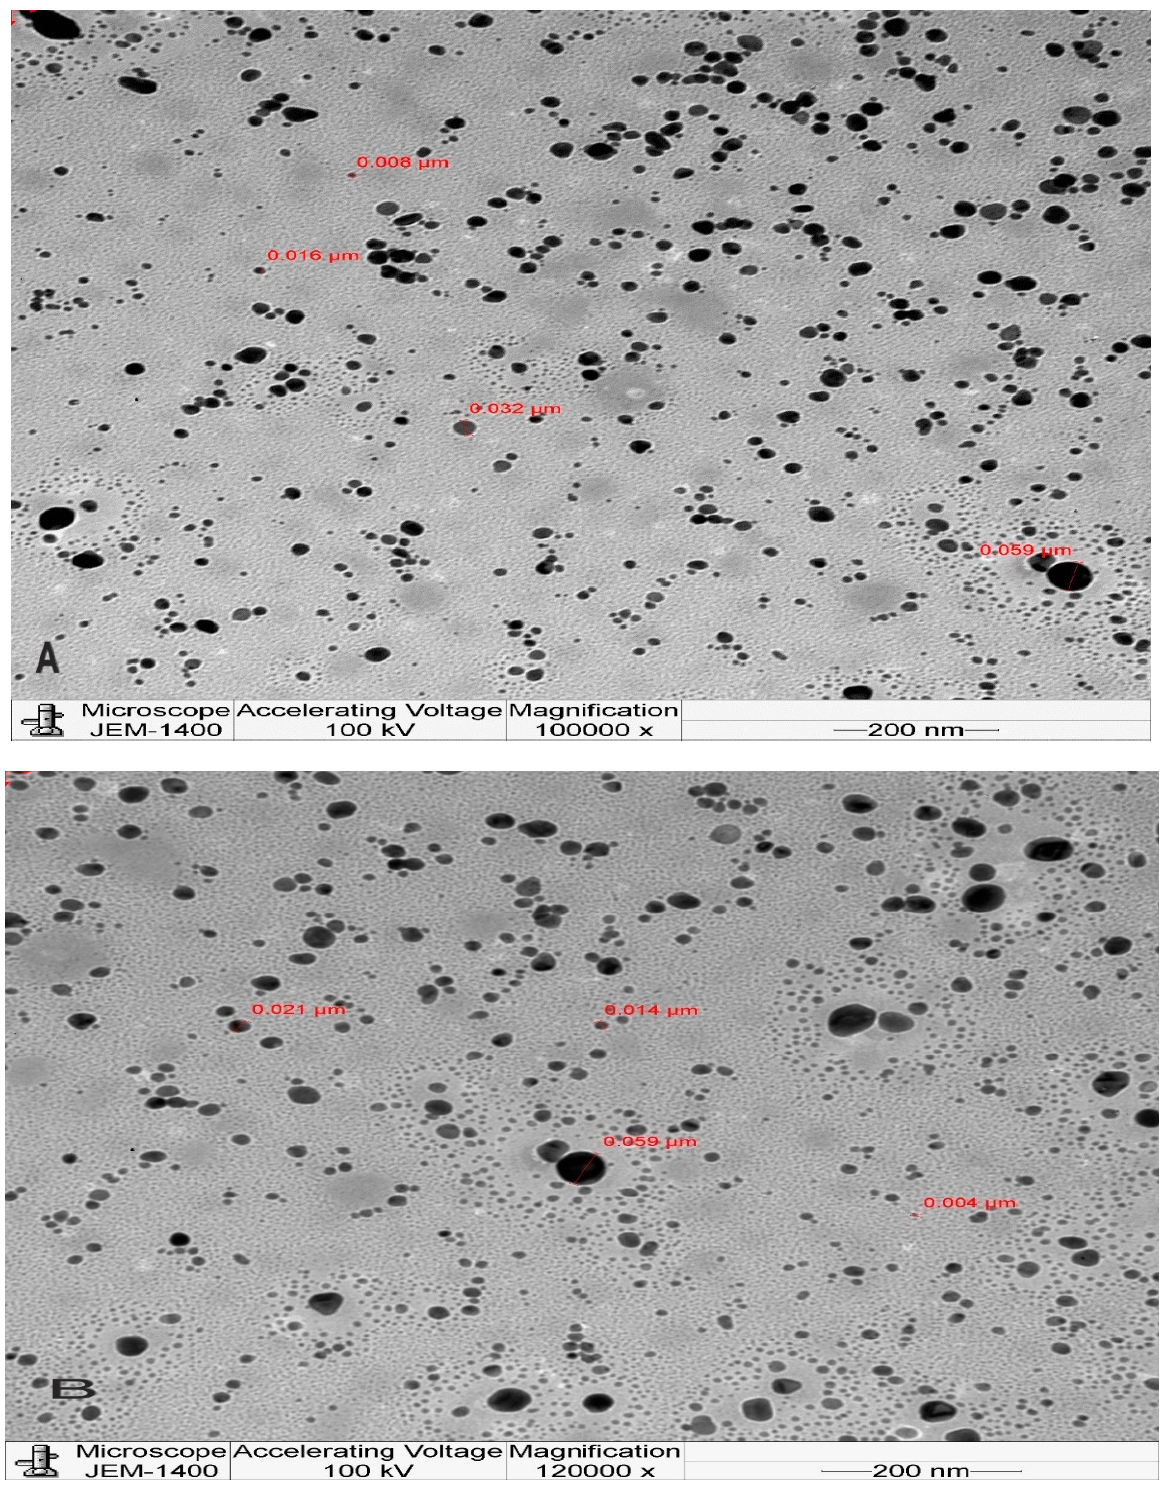
Figure 5. Transmission electron microphotographs of red currant AgNPs: ( A , B ) depicts the small size (4 to 59 nm) and spherical of AgNPs synthesised from red currant aqueous extracts.